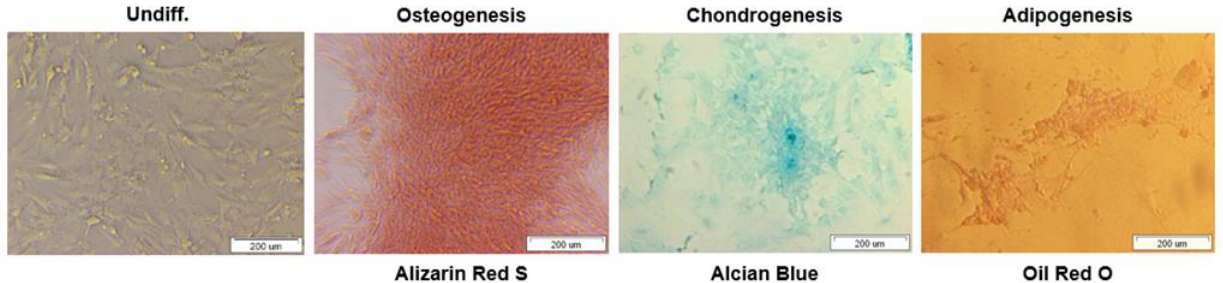
Figure 3. Differentiation of bmMSCs to osteocytes (Alizarin Red S), chondrocytes (Alcian Blue), and adipocytes (Oil Red O). Scale bars = 200 µm.